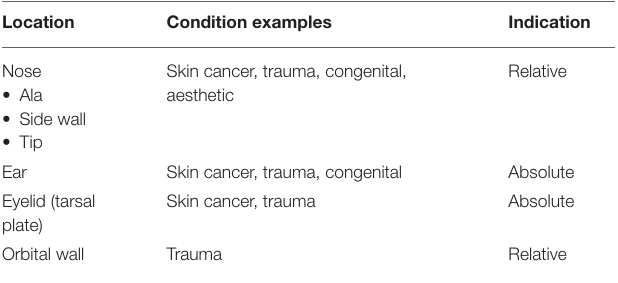
TABLE 1 | Uses of cartilage grafting in facial reconstructive